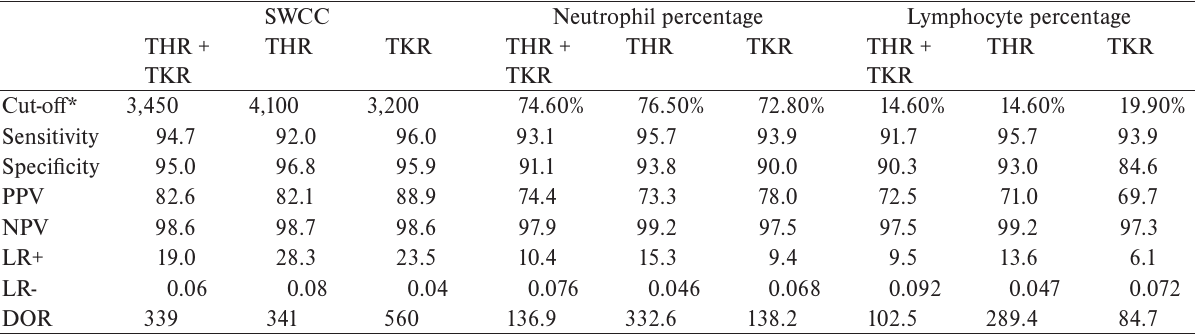
SWCC = synovial white cell count; THR = total hip replacement; TKR = total knee replacement; PPV = positive predictive value; NPV = negative predictive value; LR+ = positive likelihood ratio; LR- = negative likelihood ratio; DOR = diagnostic odds